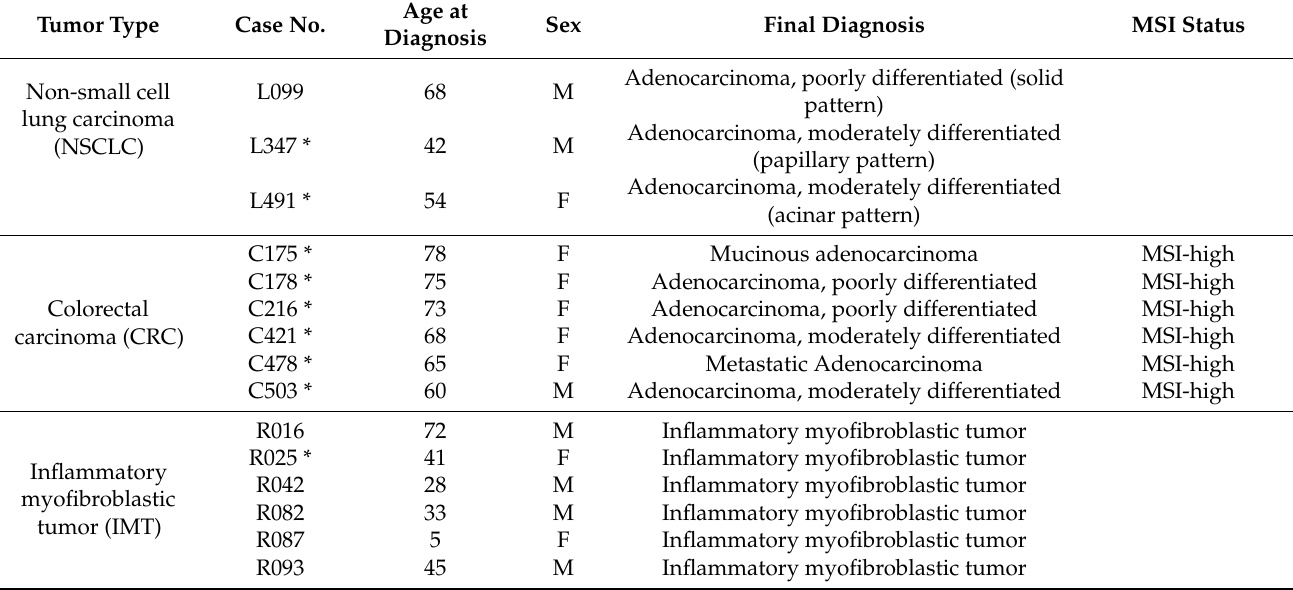
Table 1. Clinicopathological characteristics of 15 TRK expression